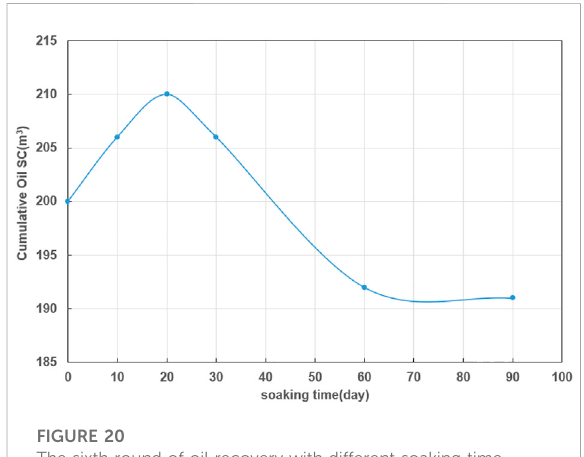
FIGURE 20 The sixth round of oil recovery with different soaking time.